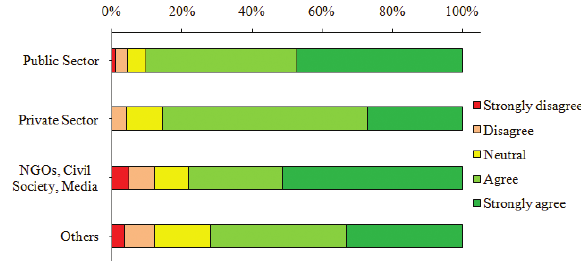
Figure A12. Occupation-wise responses to K12: “To increase